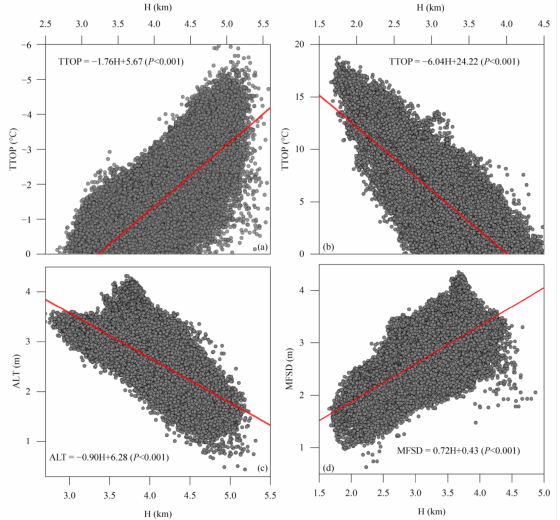
Figure 11. Correlation between altitude (H) and the temperature at the top of the permafrost ( a ) or the bottom of maximum frozen soil depth ( b ) (TTOP), active layer thickness (ALT) ( c ), and maximum frozen soil depth (MFSD) ( d ) in the Qilian